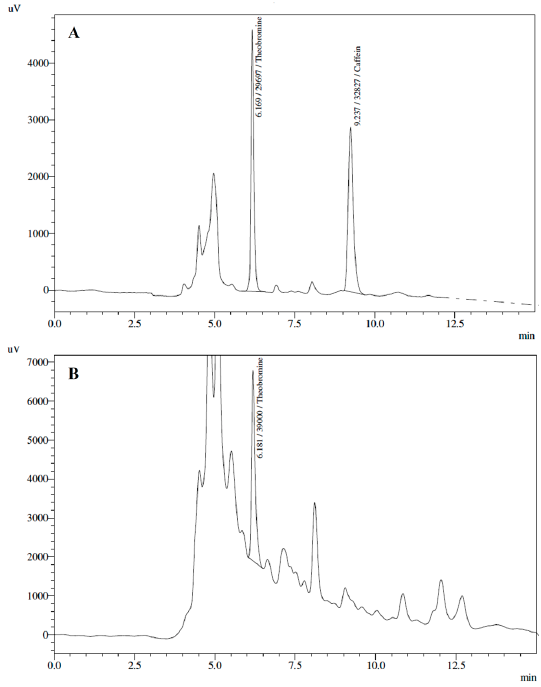
Figure 4. HPLC chromatograms of standard theobromine ( A ) and theobromine in the crude extract from cacao pod husk ( B ).